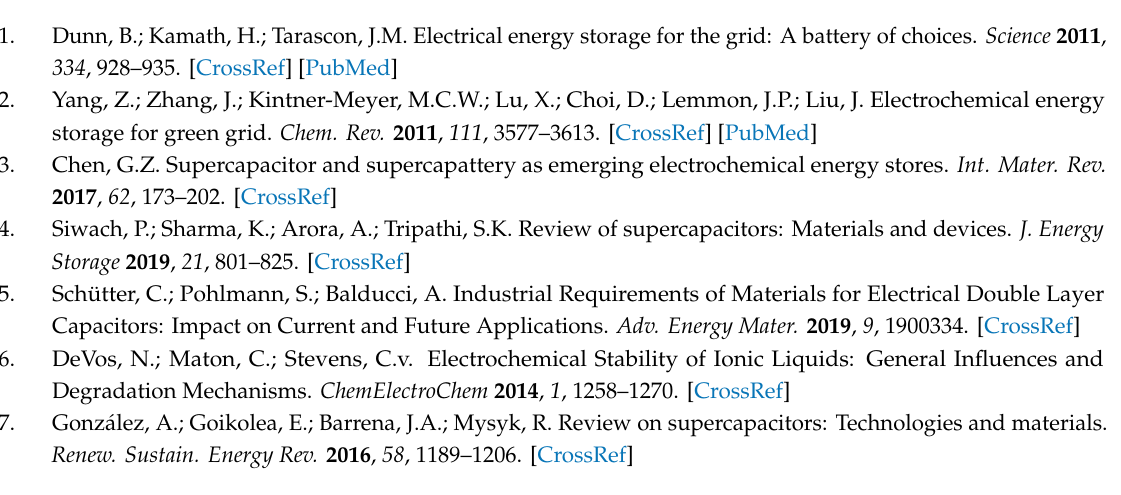
Figure S1. Schemes of the casting preparation of the pullulan-based electrodes and of the supercapacitor assembly, Figure S2. Nyquist plot of Pullulan electrospun membrane soaked with (a) PYR 14 TFSI, (c) EmimTFSI, (e) 0.5 m LiTFSI TEGDME and Cellulose triacetate electrospun membrane soaked with (b) PYR 14 TFSI, (d) EmimTFSI, (f) 0.5 m LiTFSI TEGDME, Figure S3. Trend of the capacitance percentage normalized by the value at first cycle the as function of the cycle number (at 1 A g − 1 , cell voltage cut-o ff : 0 V–3.2 V), Table S1. Resistance normalized by the plain area of Pullulan electrospun separator in di ff erent tested electrolytes, Table S2. Resistance normalized by the plain area of Cellulose triacetate electrospun separator in di ff erent tested electrolytes, Table S3. Resistivity of Pullulan electrospun separator in di ff erent tested electrolytes, Table S4. Resistivity of Cellulose triacetate electrospun separator in di ff erent tested electrolytes, Table S5. Mac Mullin number of Pullulan electrospun separator in di ff erent tested electrolytes, Table S6. Mac Mullin number of Cellulose triacetate electrospun separator in di ff erent tested